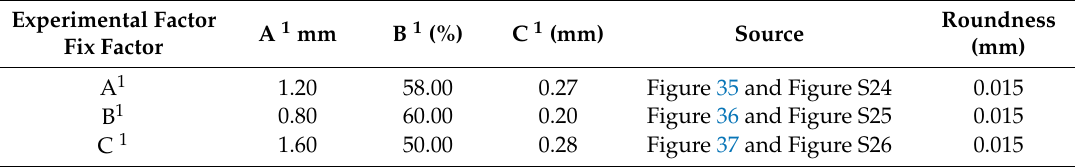
Table 9. Value of Experimental Factor for Cylinder 15 mm.